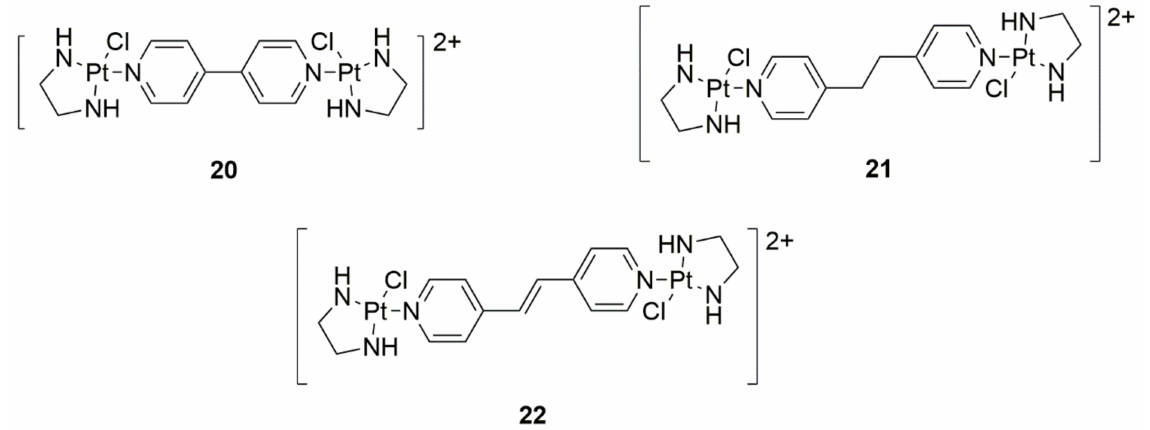
Figure 10. Structures of the new synthesized platinum structures with ( 20 ) 4,4 (cid:48) -bipyridine, ( 21 ) 1,2-bis(4-pyridyl)ethane and ( 22 )